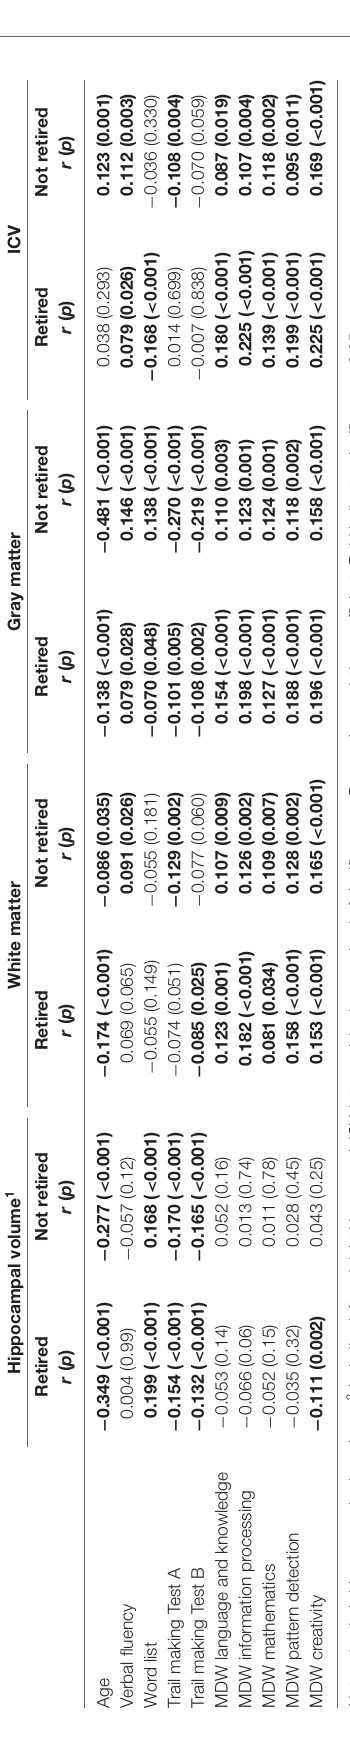
factor variables. Results are shown in Table 5 . For